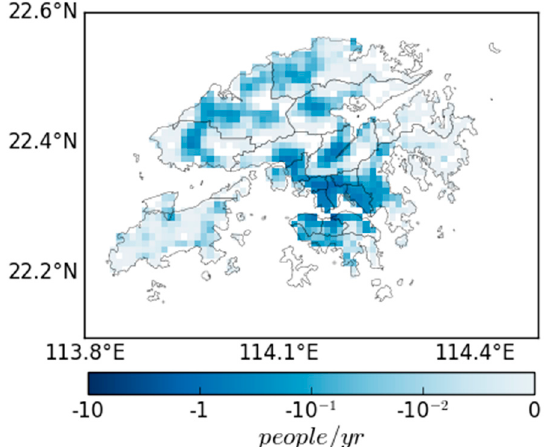
Figure 6. Spatial distribution of the reduction of premature mortality attributable to PM 2.5 over Hong Kong ( Δ Mort ) in the 804 tests that reduced PM 2.5 concentration by − 1 μ g/m 3 in different pixels.